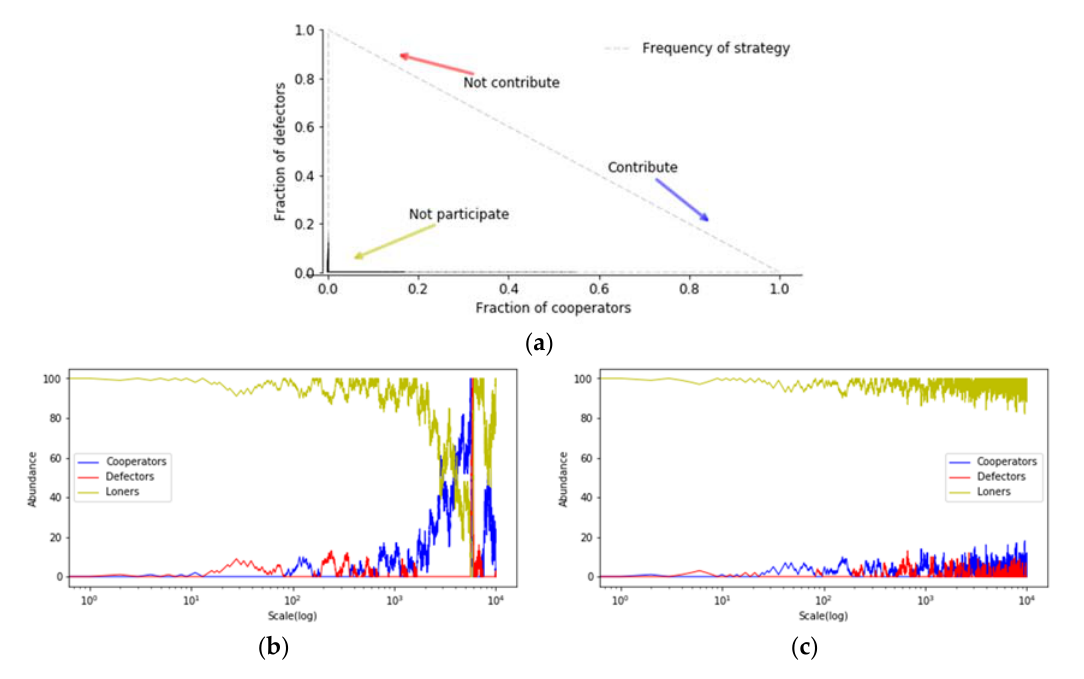
Figure 3. The upper (a) and bottom left (b) plots include the participation cost (g). The parameters are N = 5, r = 3, c = 1, and g = 2. The right bottom plot (c) corresponds to g = 3. Both plots on the bottom side (b, c) show the categorized oscillation of the strategies (cooperators = blue, defectors = red, loners = yellow).